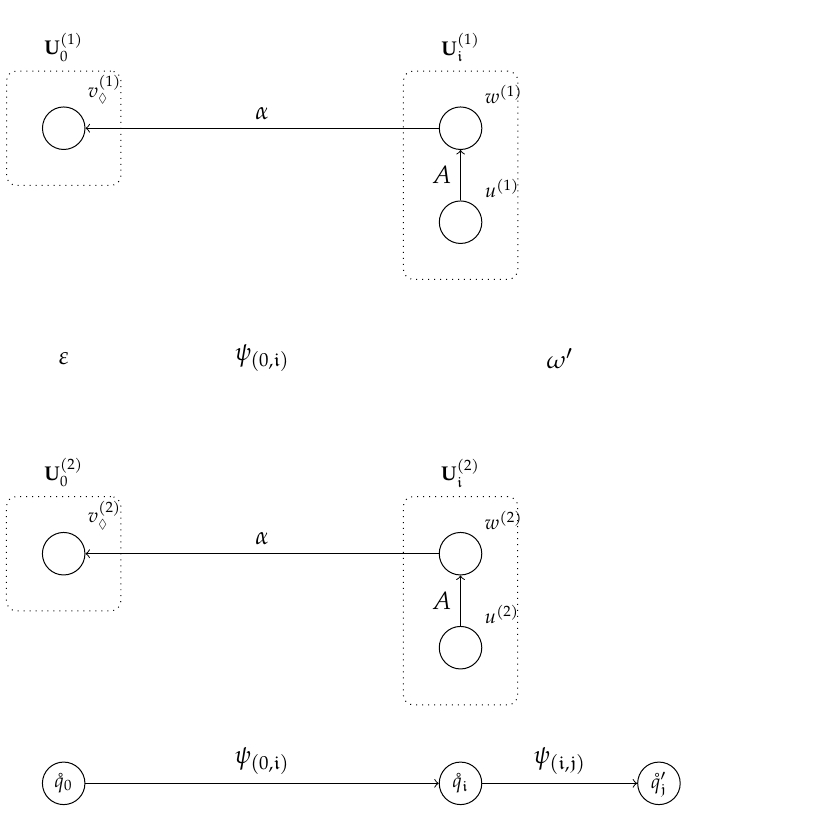
Figure 24. The relevant part of Γ p 1 q after the ε -reduce action is performed by the character-level RNGLR and the corresponding part of Γ p 2 q after the ε -reduce action is performed by our architecture.